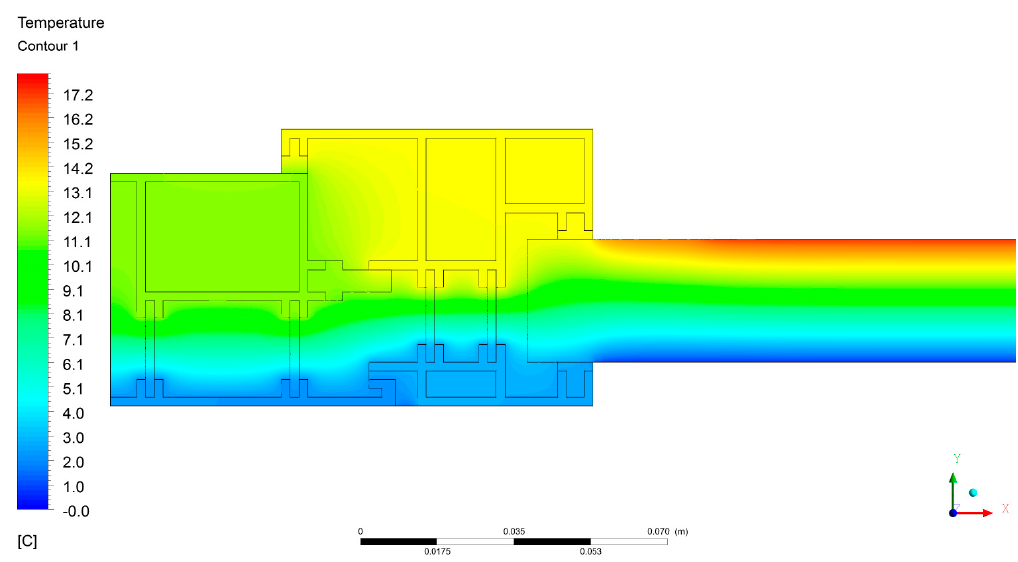
Figure 2. Temperature distribution on aluminum frame, example I1 from ISO 10077-2.